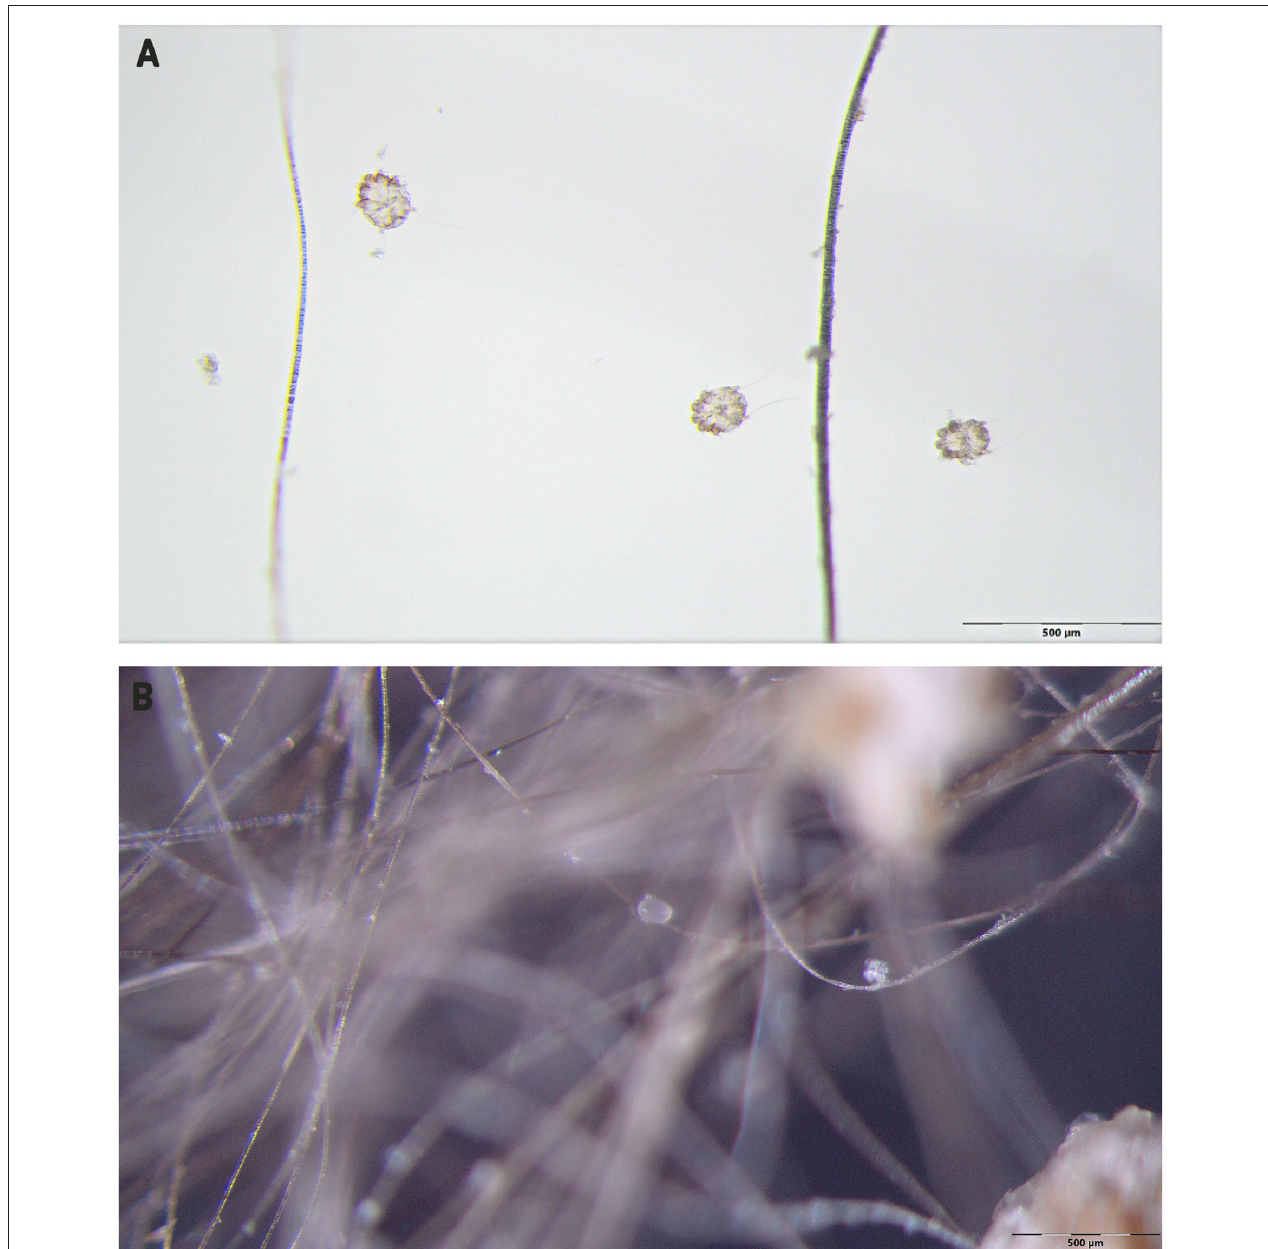
FIGURE 2 | Notoedres cati identified through an stereomicroscope examination of the coat brushing ( A , adults; B ,